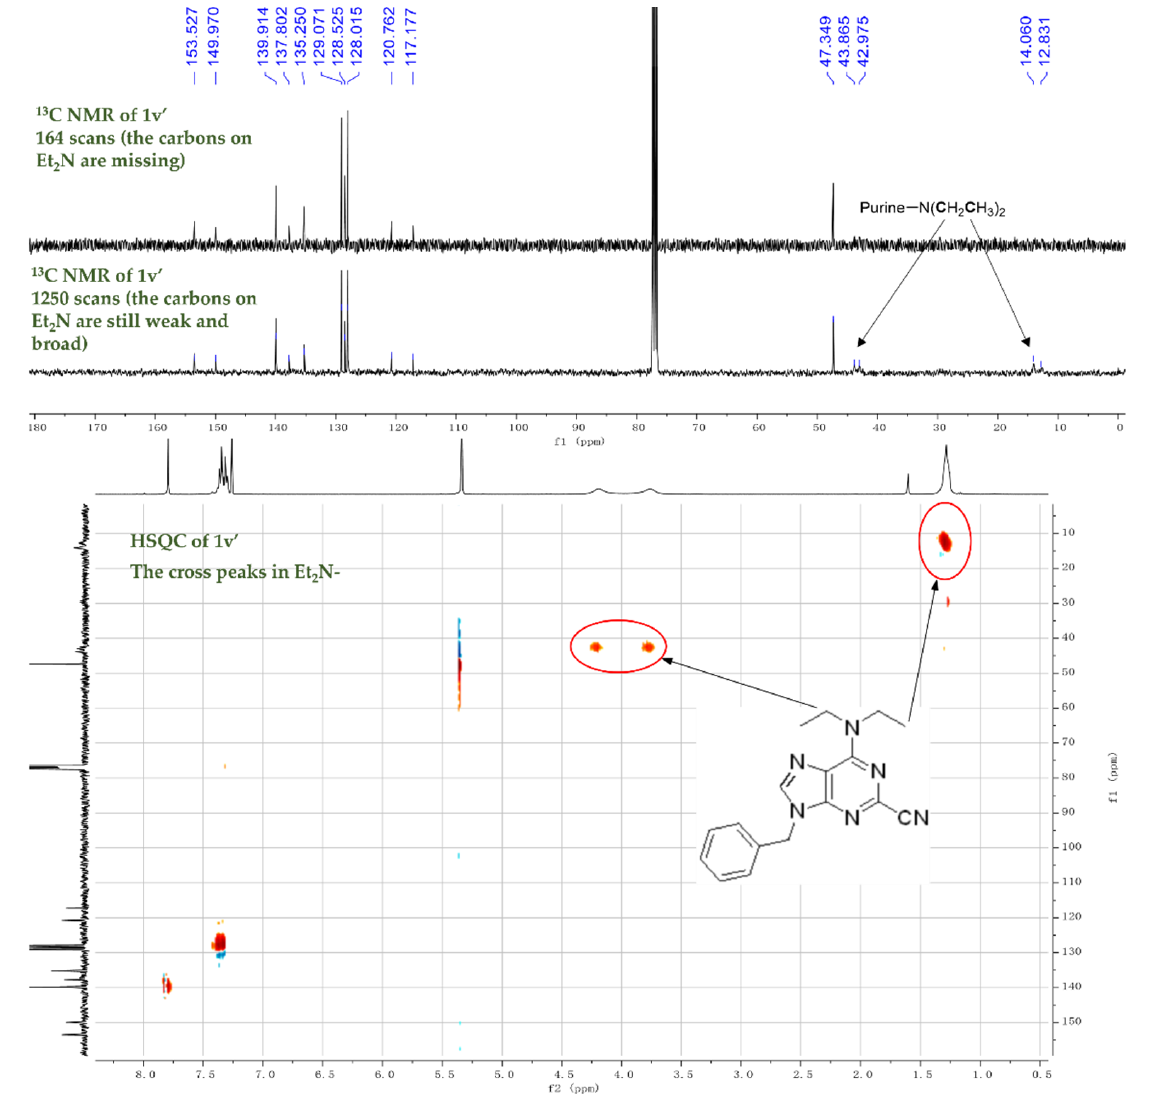
Figure 1. The 13 C NMR (101 MHz; 164 scans and 1250 scans) and the HSQC of 2v’ (the structure identification of the broad and weak carbons in Et 2 N). The sample was prepared from 10 mg of 2v in 0.5 mL CDCl 3 .